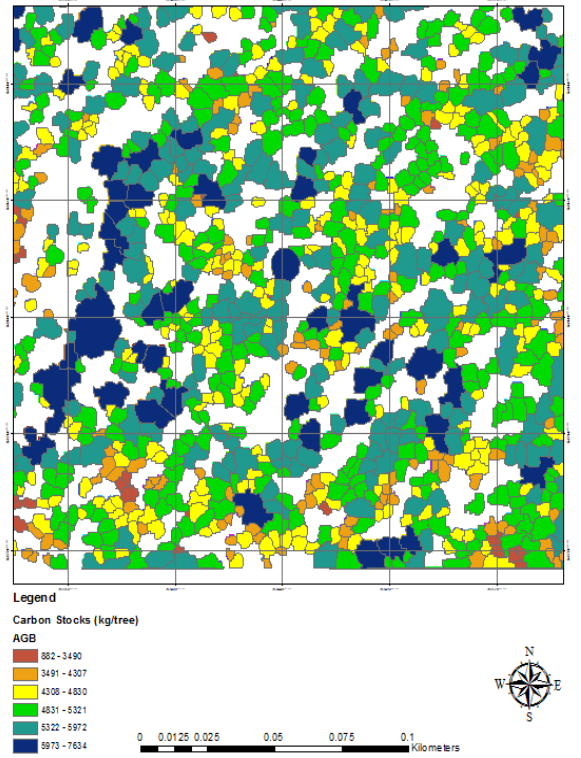
Figure 9. Carbon stocks of the study